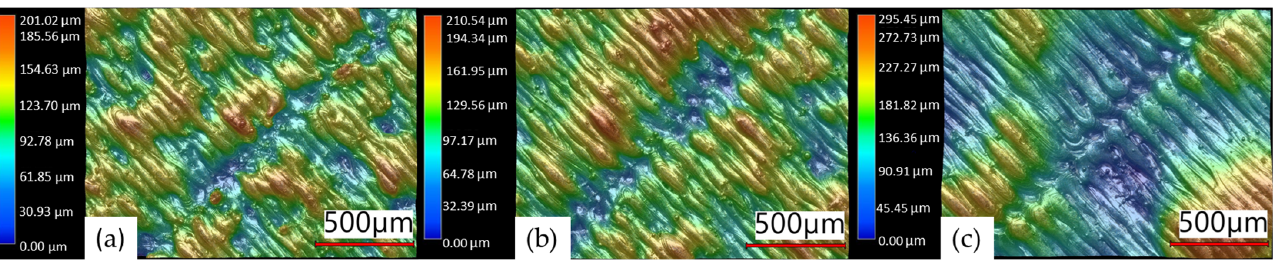
Figure 18. Top surface of ( a ) low-LED test piece (0.23 J/mm), ( b ) reference LED test piece (0.33 J/mm) and ( c ) high-LED test piece (0.50 J/mm).